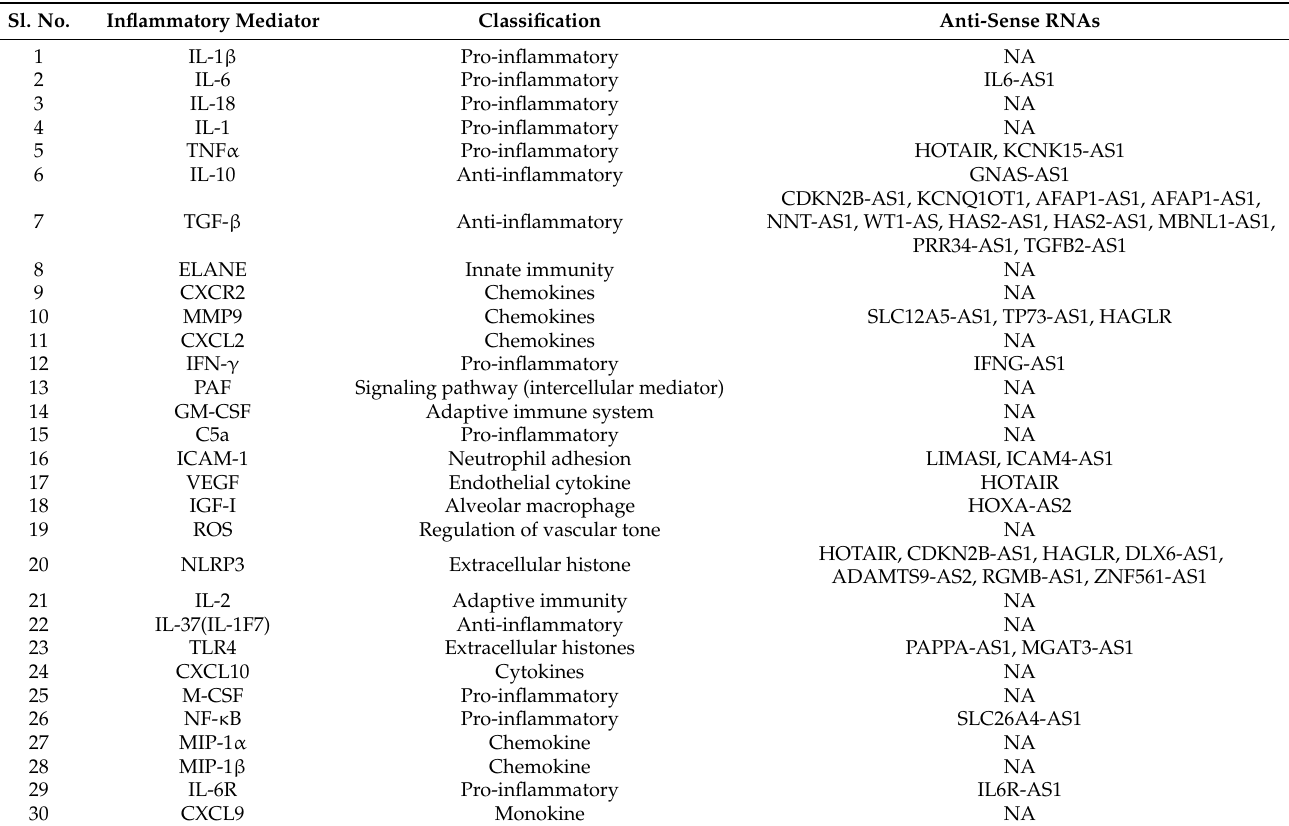
Table 3. Inflammatory mediators involved in ARDS and associated anti-sense RNA as reported in the NCBI